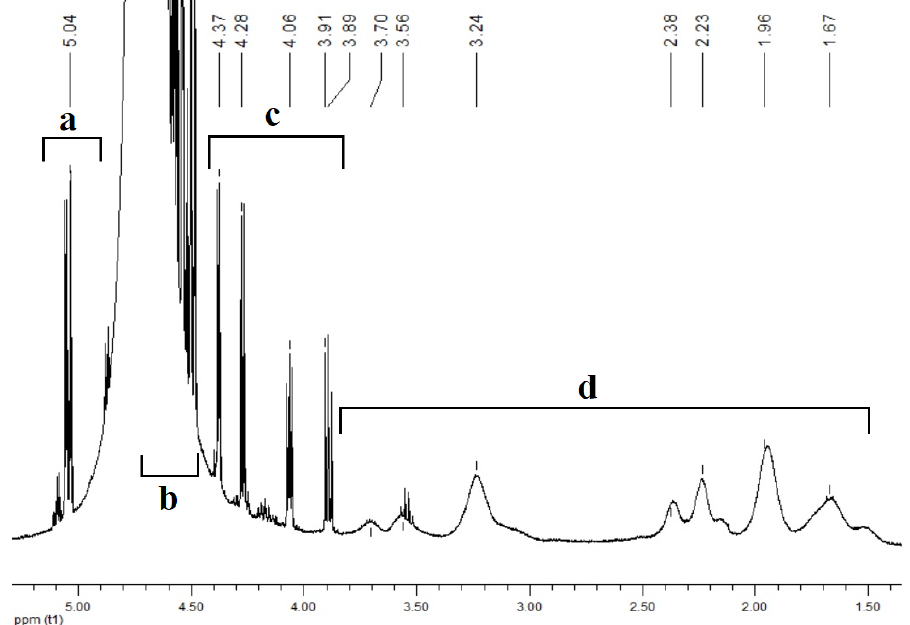
Figure 7. 1 H NMR spectrum of the complex [N-VP] n -[N-VA] m [1,4- and 6,3-GL]. Area (a) (5 ppm), (b) 4.5 – 4.7 ppm, (c) 3.9 – 4.4 ppm, (d) 1.5 – 3.8 ppm. (b) 4.5–4.7 ppm, (c) 3.9–4.4 ppm, (d) 1.5–3.8